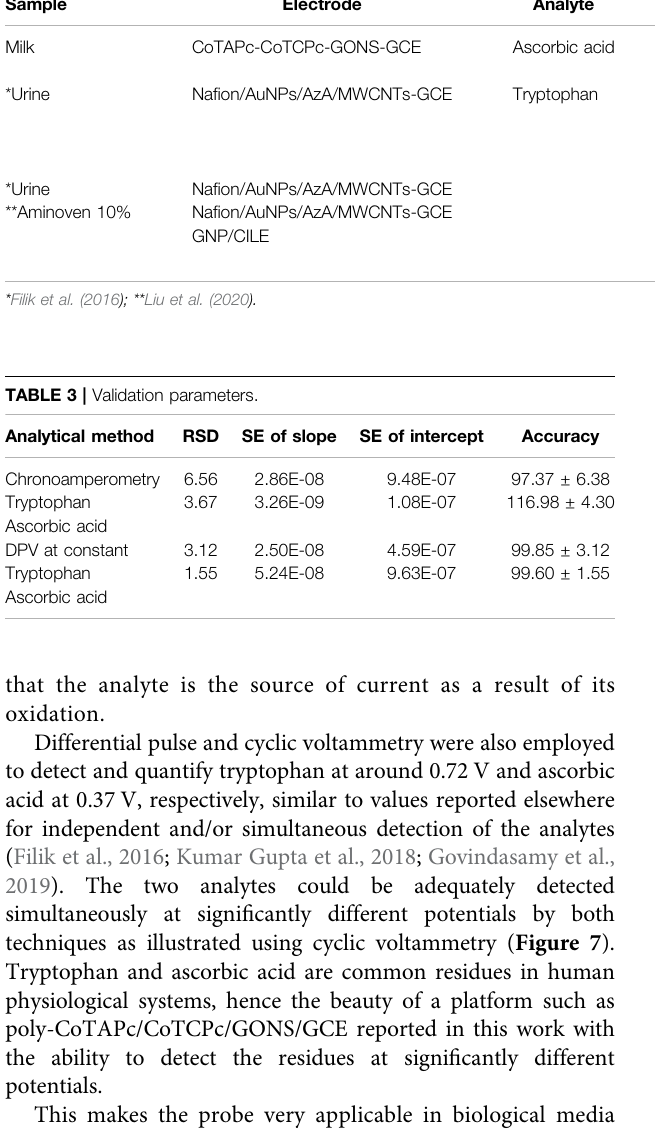
TABLE 2 | Determination of ascorbic acid and tryptophan in milk and urine samples using poly-CoTCPc-CoTAPc-GONS/GCE. Sample